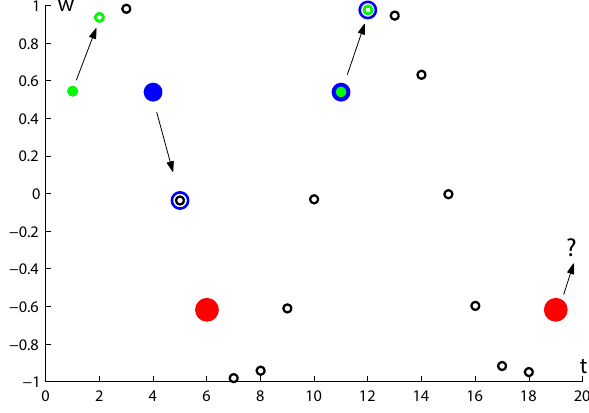
Figure A1. Computation of λ . Synthetic signal vs. time (see text).